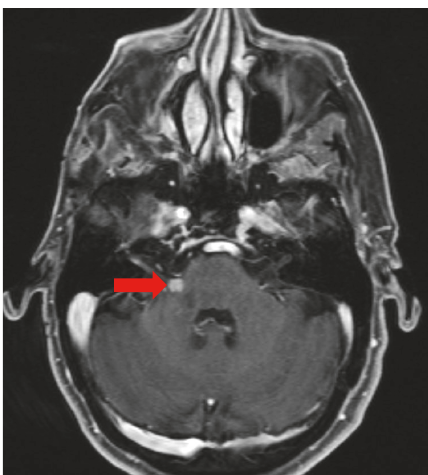
Figure 3: T1-weighted image with contrast, highlighting new right- sided cerebellopontine angle lesion